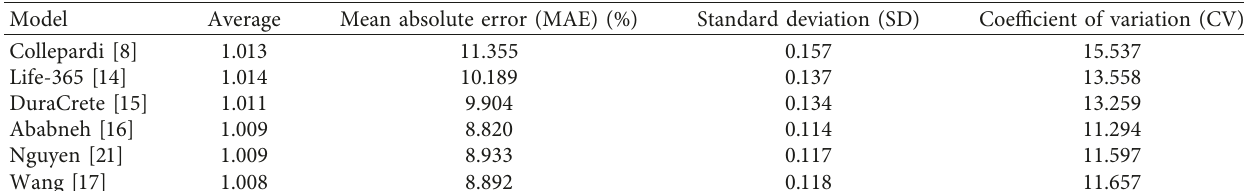
Table 4: Accuracy of different models for predicting chloride diffusion in marine concrete